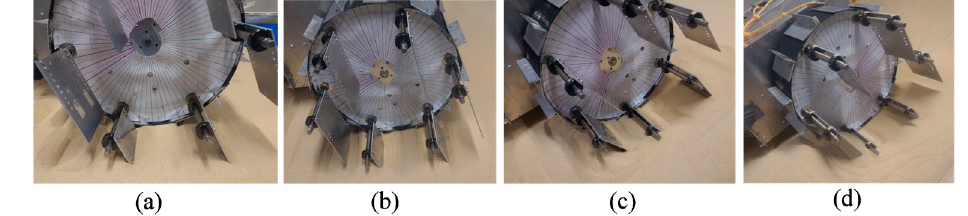
Figure 14. Modified wheeled rover with assistive grouser attached using the optimum configurations: ( a ) Φ d = 20 degrees at level incline; ( b ) Φ d = 20 degrees at 10 degree incline; ( c ) Φ d = 40 degrees at 20 degree incline; ( d ) Φ d = 40 degrees at 30 degree incline.